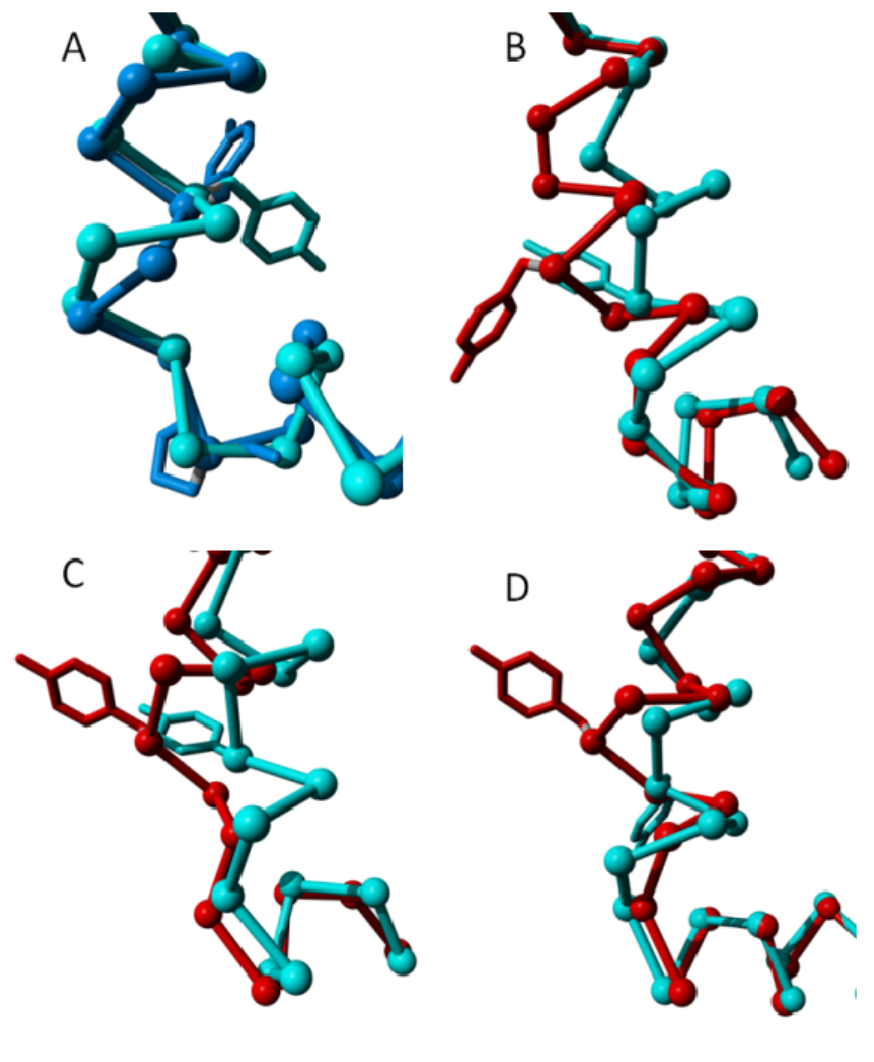
Figure 11. Structural variability in the intracellular part of helix VII near residue Tyr733. In all four panels the cytosolic side of helix VII and the beginning of helix VIII are shown as a trace model and the Tyr733 side chain is shown as a stick model. In all four panels helix VIII points to the right. ( A ) Cyan represents inactive rhodopsin (PDBid = 1f88 [2]), blue represents inactive β 2 adrenoceptor (PDBid = 3ny9 [12]). After Tyr733, rhodopsin forms a normal helix and the β 2 adrenoceptor forms a 3 helix, which is followed by a 10 proline at the beginning of helix VIII. In the Panels B – D , cyan represents the inactive state, red represents the active state; ( B ) Adenosine A2A receptor. Cyan: PDBid = 3eml [46]. Red: PDBid = 2ydo [14]; ( C ) β 2 adrenoceptor. Cyan: PDBid = 3ny9 [12]. Red: PDBid = 3sn6 [11]; and ( D ) Rhodopsin. Cyan: PDBid = 1f88 [2]. Red: PDBid = 3cap [50]. In rhodopsin and the adenosine A2A receptor, a bulge is formed upon activation. In the β 2 adrenoceptor the inactive state has a 3 helix, which becomes a normal helix 10 upon